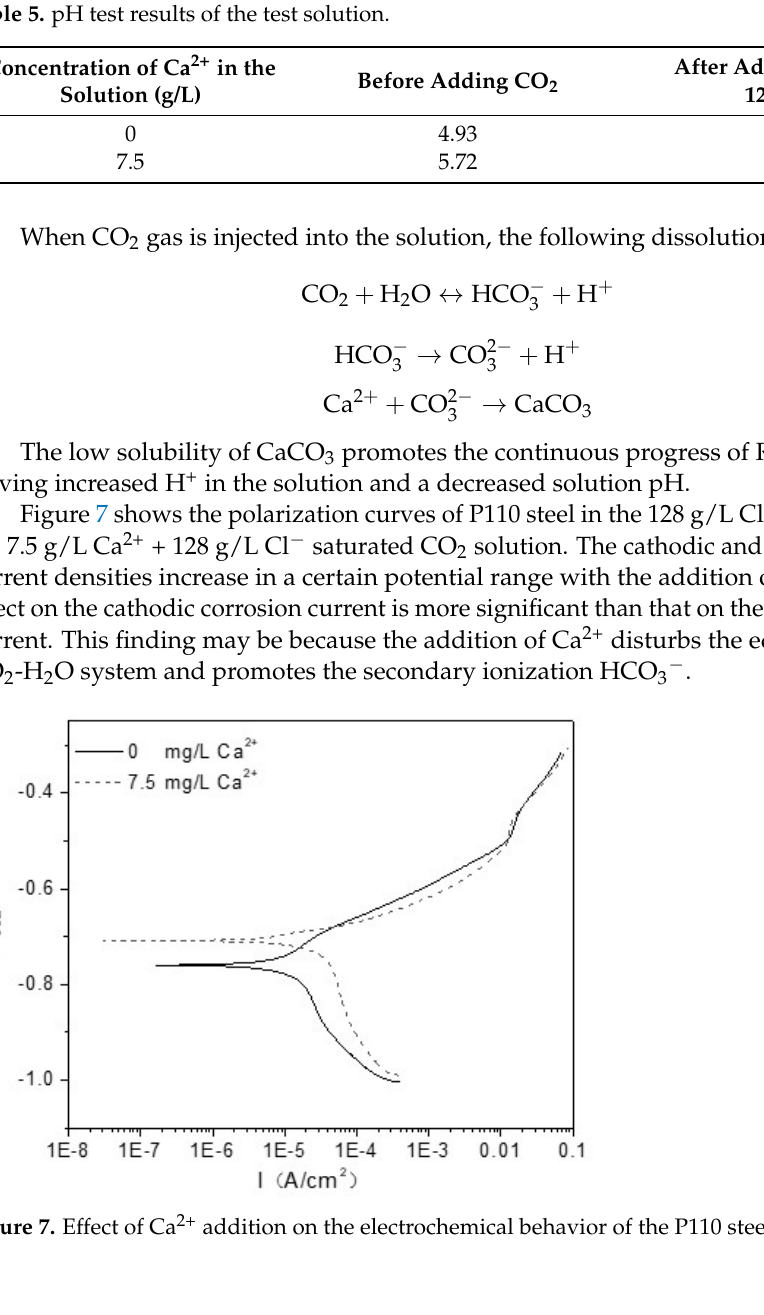
Figure 8. Polarization curves and EIS impedance curves of P110 steel at different flow rates: ( a ) polarization curves; ( b ) EIS curves. For the four groups of specimens immersed for 72 h, the anodic dissolution current density is less affected by the corrosion potential, indicating that a corrosion scale forms on the surface of specimen and inhibits the diffusion of ions. The corrosion is predomi- nantly controlled by resistance polarization. According to the fitting results listed in Table 6, 72 h of continuous immersion does not form effective protective film on the surface of the specimen. The research specimens achieved their maximum corrosion current density (21.10 μ A/cm 2 ) at 120 r/min and their minimum corrosion current density (7.62 μ A/cm 2 ) in a static environment (0 r/min).